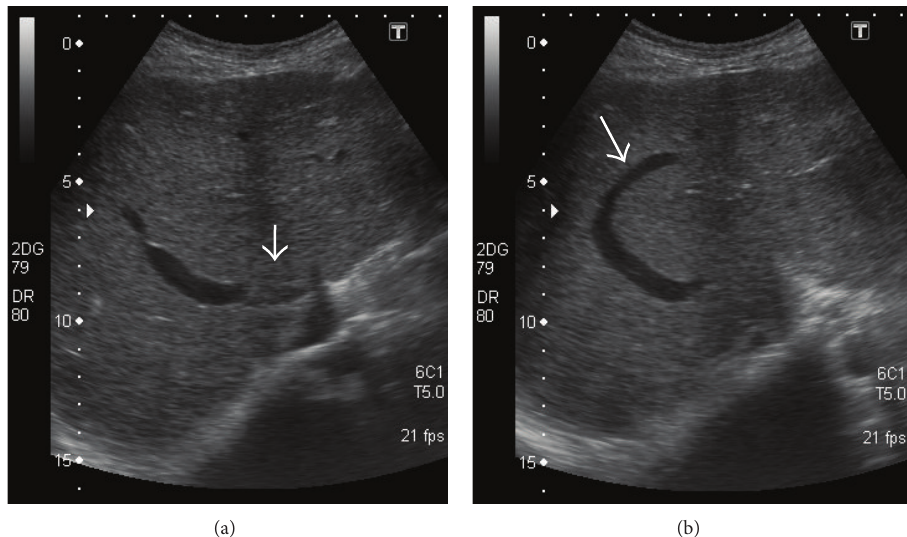
Figure 24: Gray-scale US images demonstrating thrombosed distal portion of right hepatic vein (arrow in (a)) with a typical comma-shaped venovenous collateral (arrow in (b)).